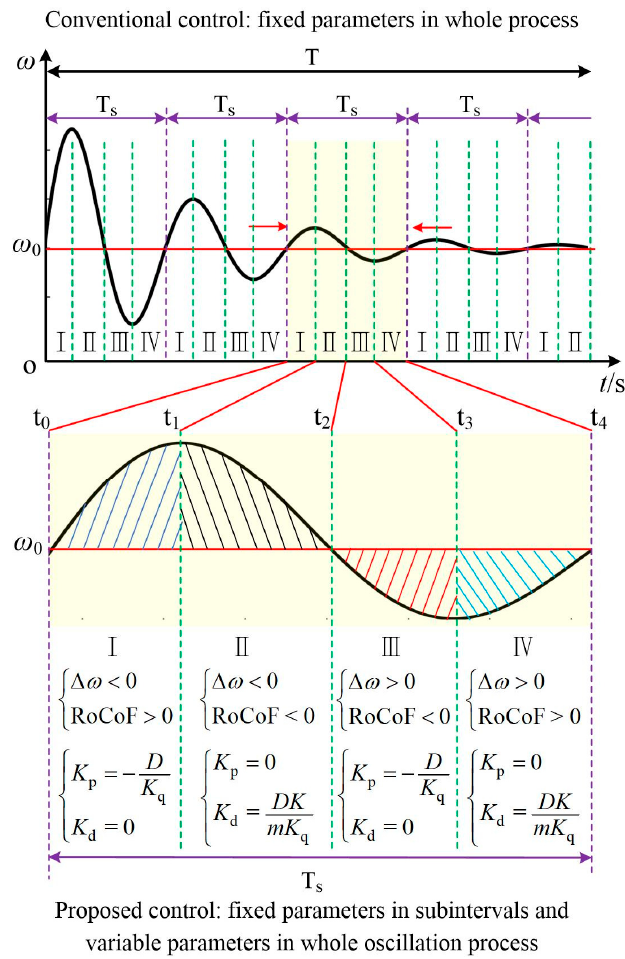
Figure 7. Illustration of proposed control scheme and its parameter design method.